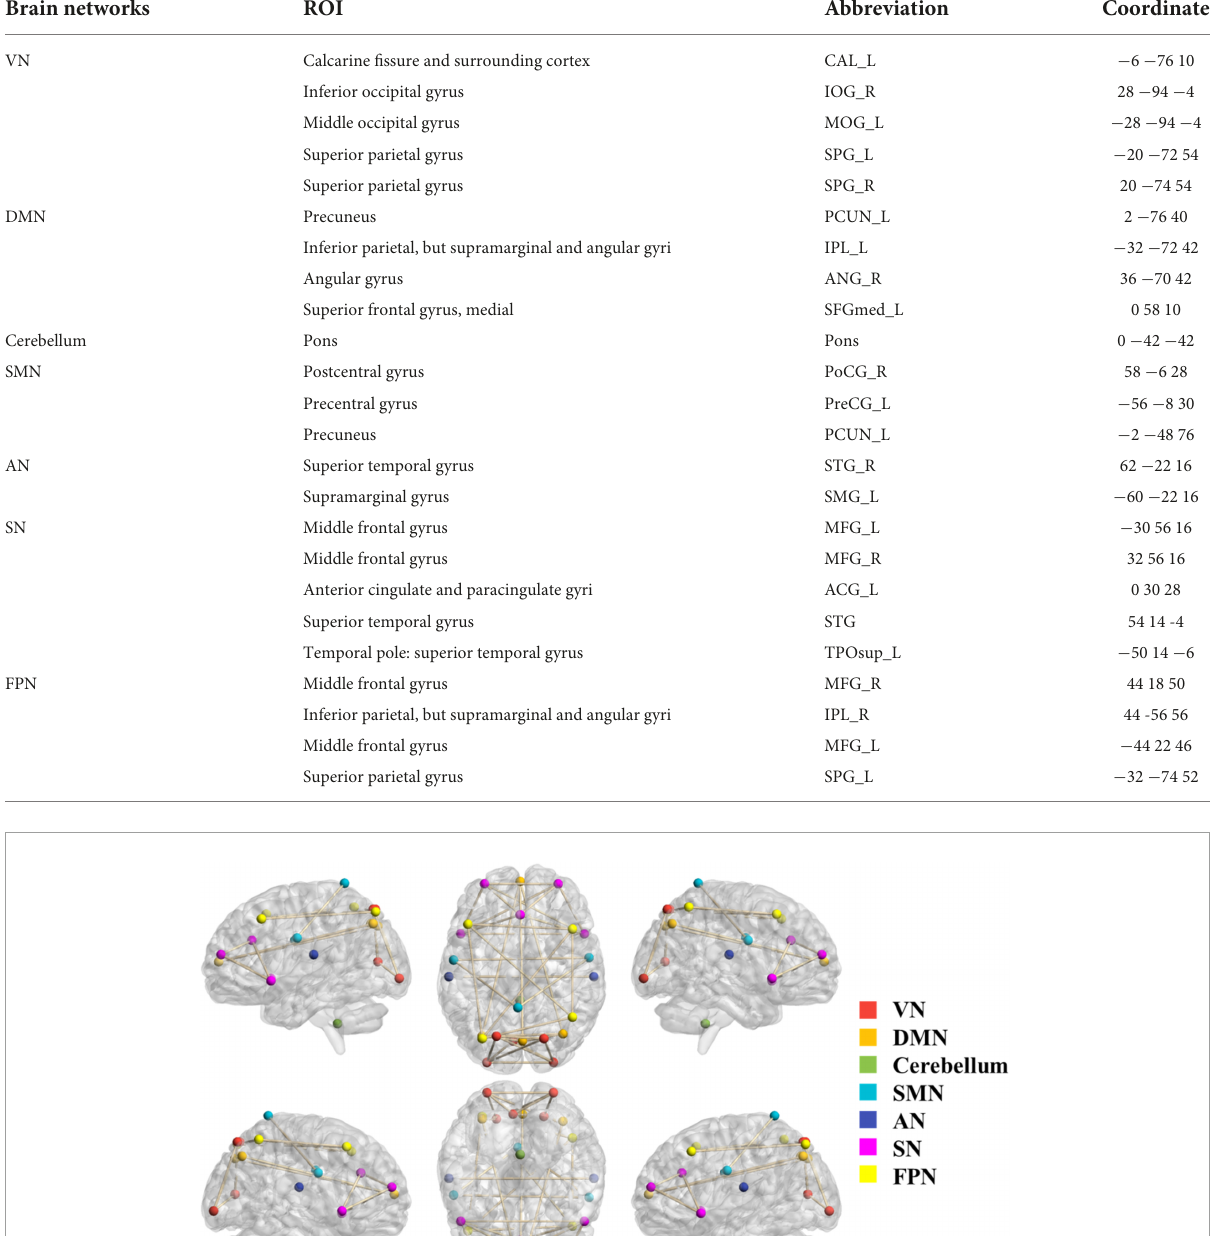
TABLE 2 The coordinates of different brain networks. Brain networks